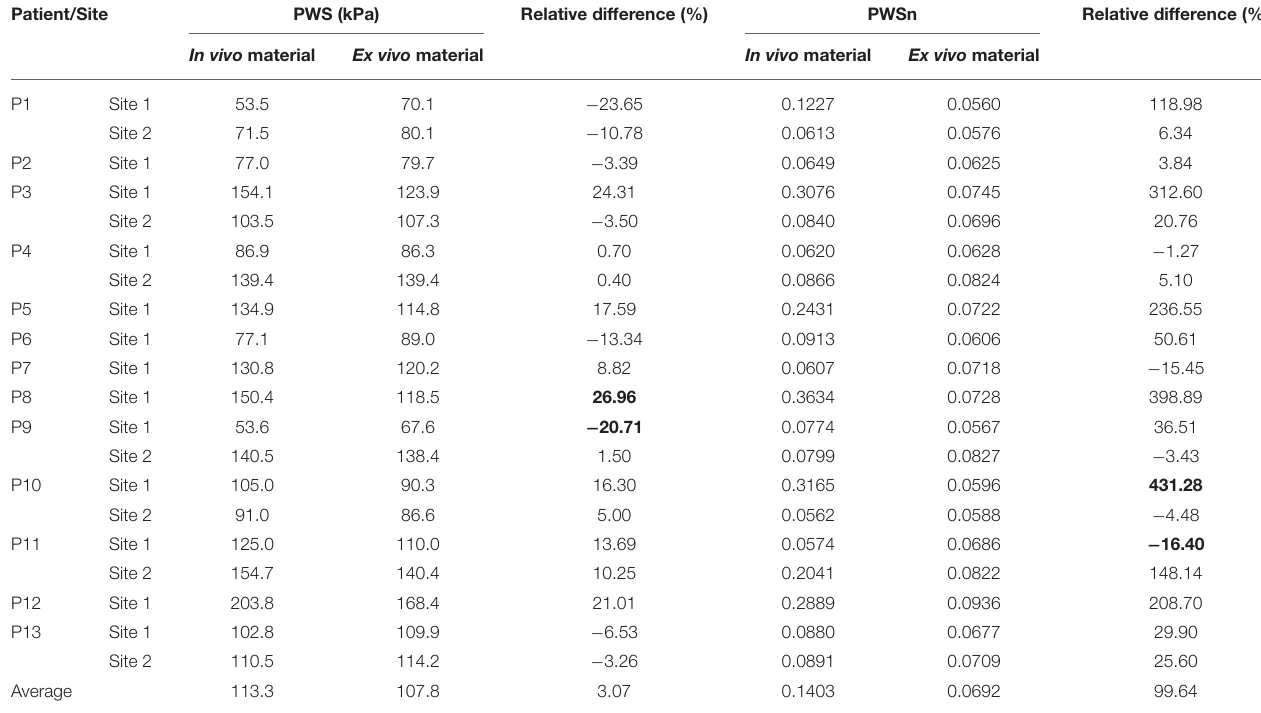
TABLE 3 | Comparison of average values of plaque wall stress/strain (PWS/PWSn) on luminal surface from thin-slice structure-only models with in vivo and ex vivo materials. Patient/Site PWS (kPa) Relative difference (%) PWSn Relative difference